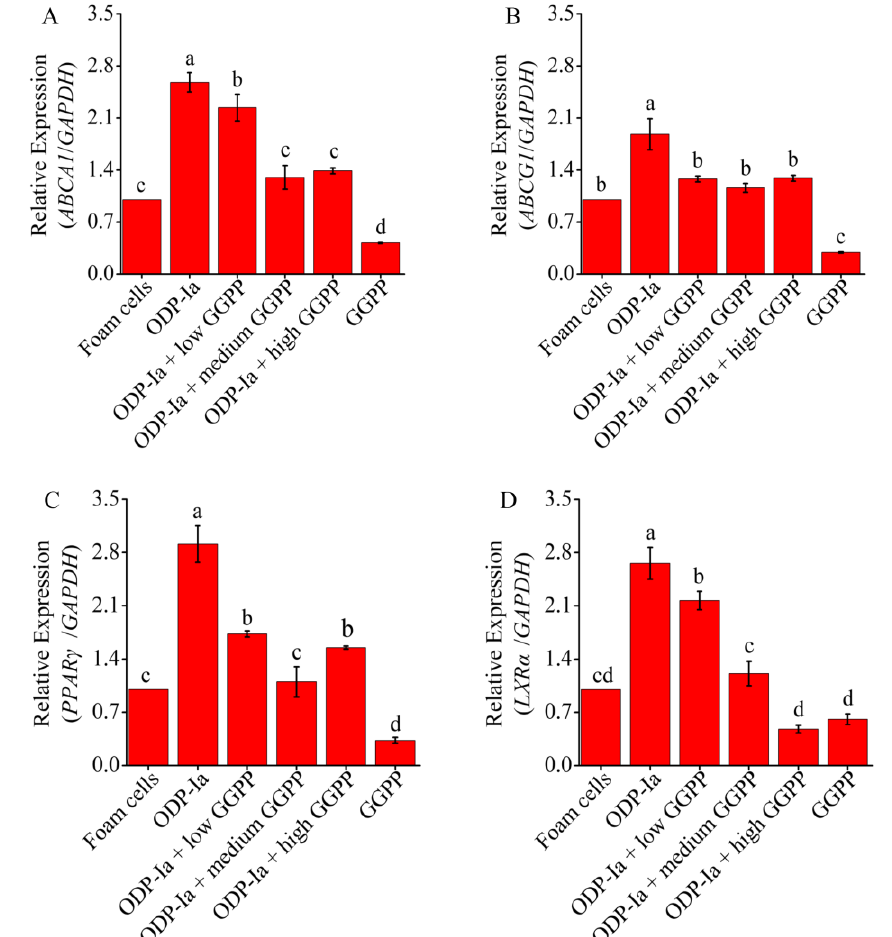
Figure 8. mRNA expression of cholesterol efflux associated gene mediated by GGPP and ODP-Ia. (mean ± SD, n = 3). ( A ) ABCA1 mRNA. ( B ) ABCG1 mRNA. ( C ) LXRα mRNA. ( D ) PPARγ mRNA. Different superscript letters indicate multiple comparisons with significant differences (SNK-q test, p < 0.05).